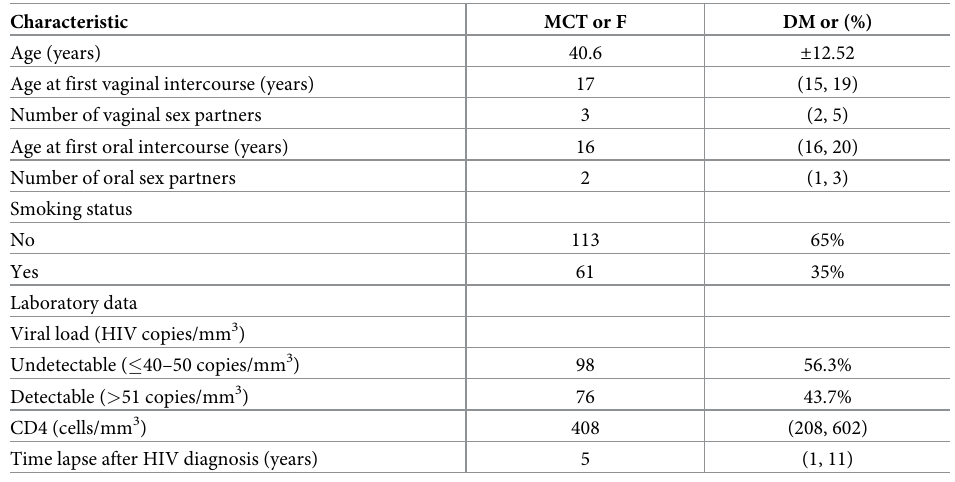
Table 1. Sociodemographic, clinical, and sexual behavior baseline data of HIV-positive women included in this study. Number of patients = 174.